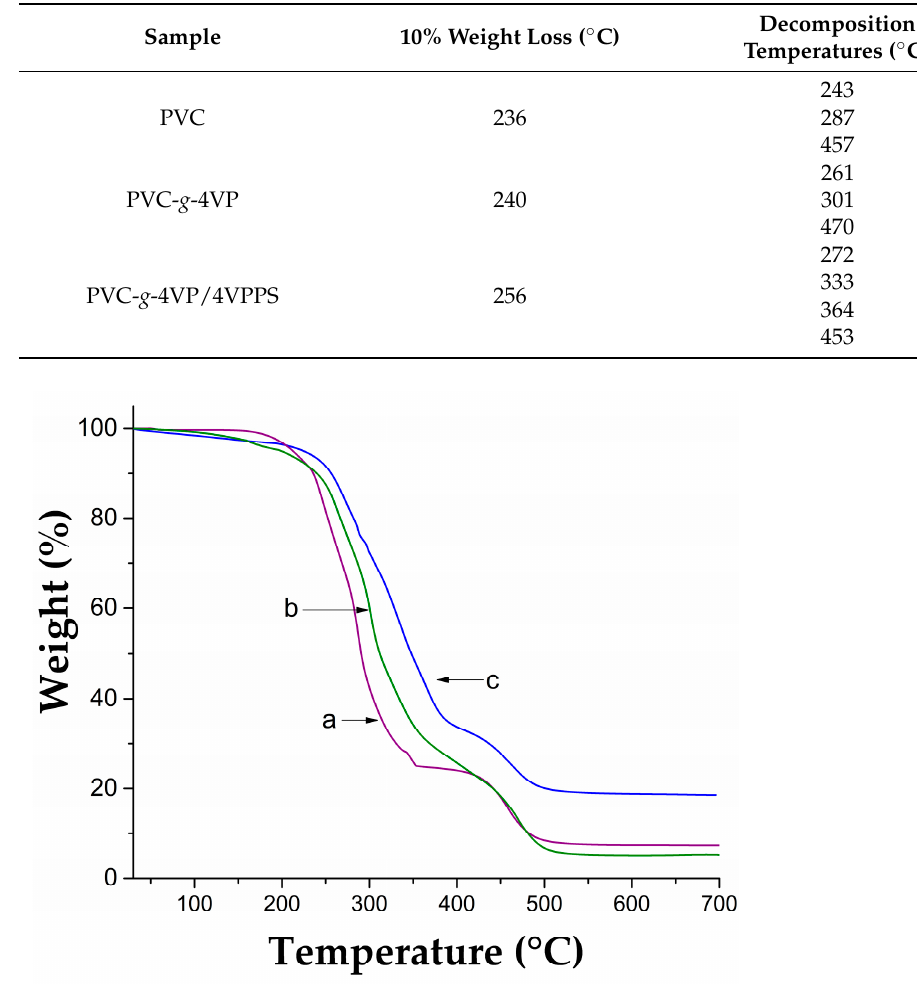
Figure 4. Thermograms: ( a ) PVC, ( b ) PVC-g-4VP, and ( c ) PVC-g-4VP/4VPPS .